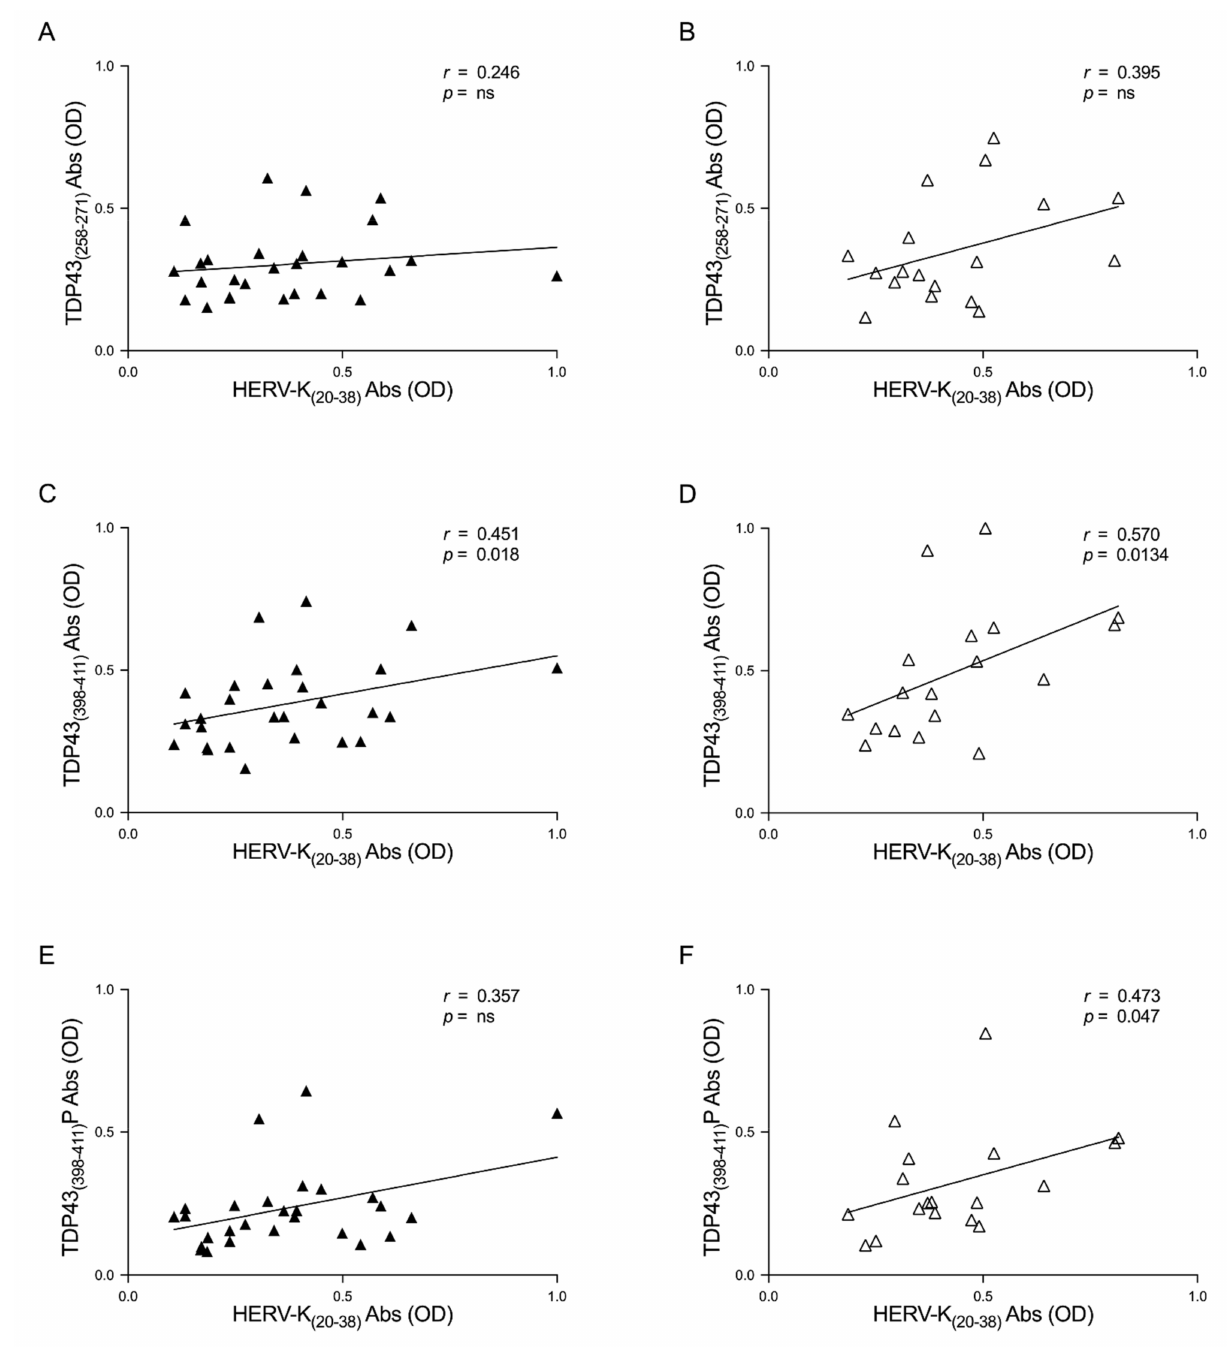
Figure 4. Scatter plots of antibodies to TDP-43-derived peptides and HERV-K env epitope in ALS populations. The graphs show the correlation between HERV-K-env-su (20–38) and TDP-43 (258–271) , TDP-43 (398–411) , and TDP-43 (398–411) P in ALS-ND patients ( A , C , E ) and in ALS-LS ( B , D , F